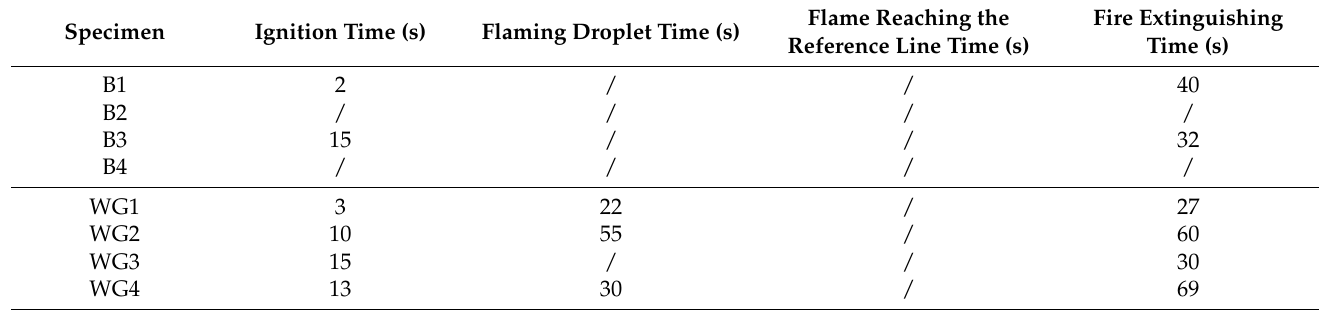
Table 2. Resistance to fire properties for the specimens with a thickness of 30 mm.